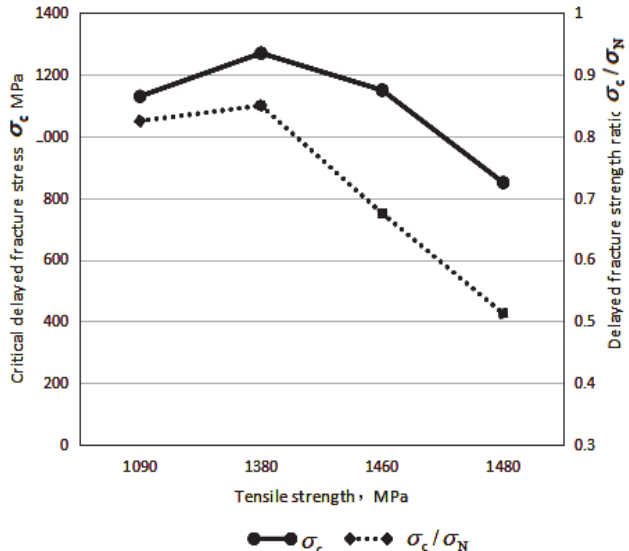
Figure 4: Variation of critical fracture stress and delay fracture ratio of the experimental materials along with the changes of tensile strength.